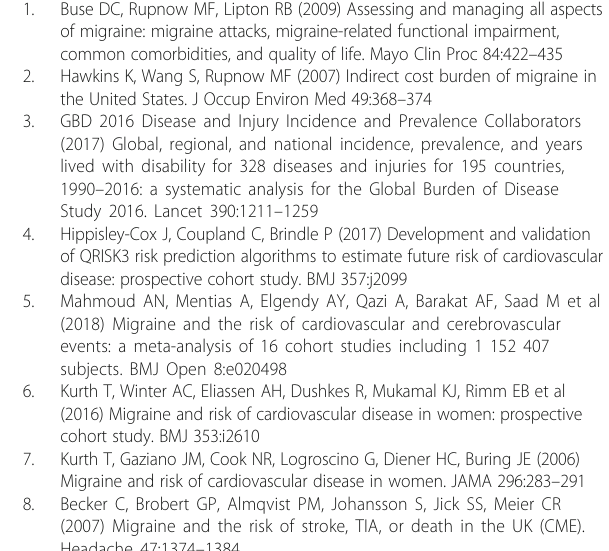
MedDRA Queries/Preferred Terms. Table S3. Summary and analysis of likely cardiovascular adverse events within Standardized MedDRA Queries/Preferred Terms . Table S4. Summary of likely cardiovascular adverse events within Standardized MedDRA Queries/Preferred Terms in patients with and without aura. Table S5. Summary of likely cardiovascular treatment-emergent adverse events within Standardized MedDRA Queries/Preferred Terms in patients with and without aura. (DOCX 39